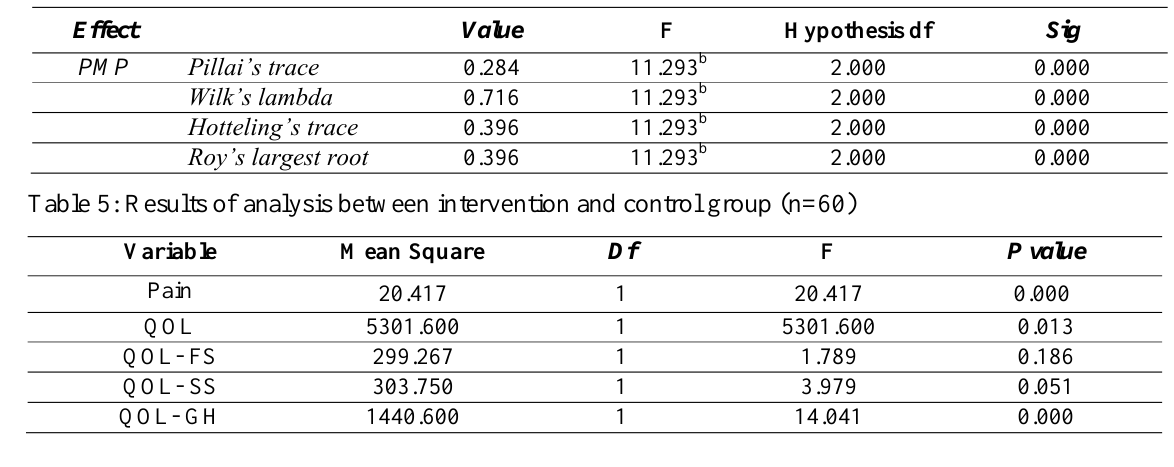
Table 4: Differences test between intervention and control group (n=60) Effect